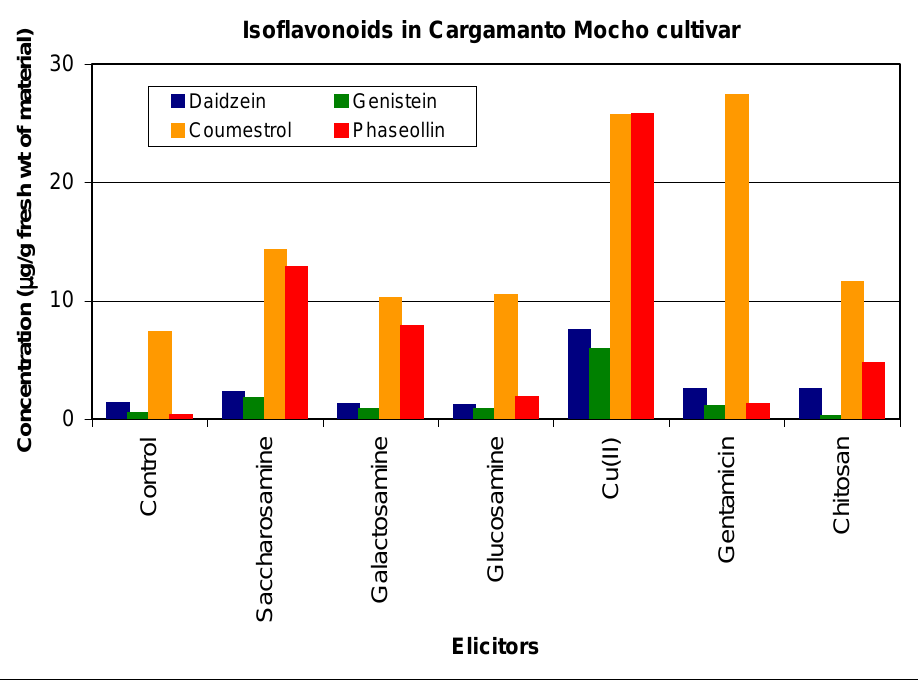
Figure 3 . Accumulation of phytoalexins in (cid:147)Cargamanto Mocho(cid:148) bean Isoflavonoids in Cargamanto Mocho